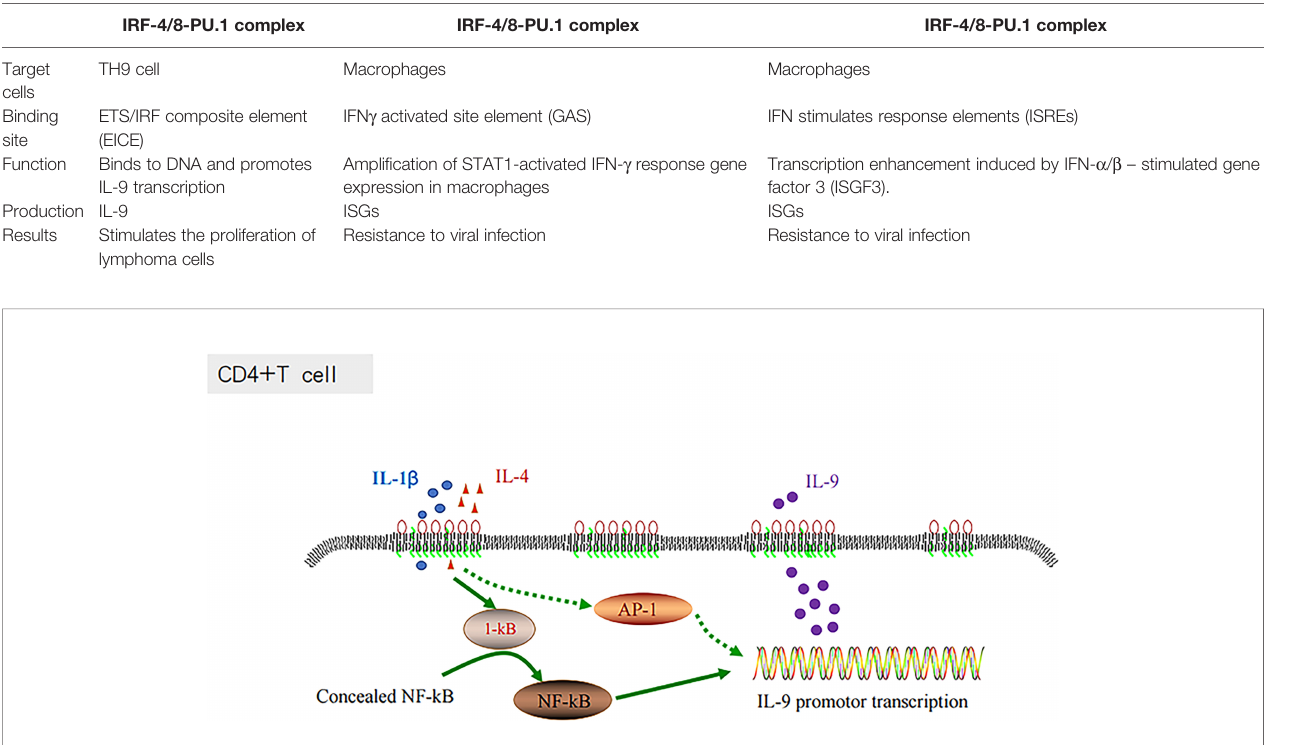
TABLE 1 | IRF-8-IL-9 regulatory pathway and other IRF-8 regulatory